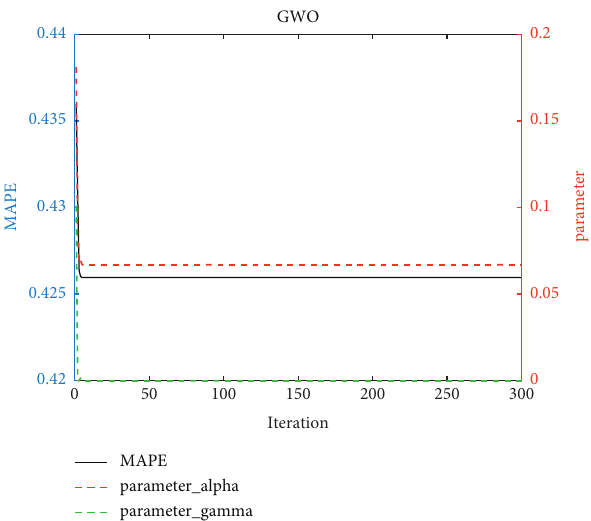
Figure 3: Iterations, MAPE, and parameters of the GWO algorithm.